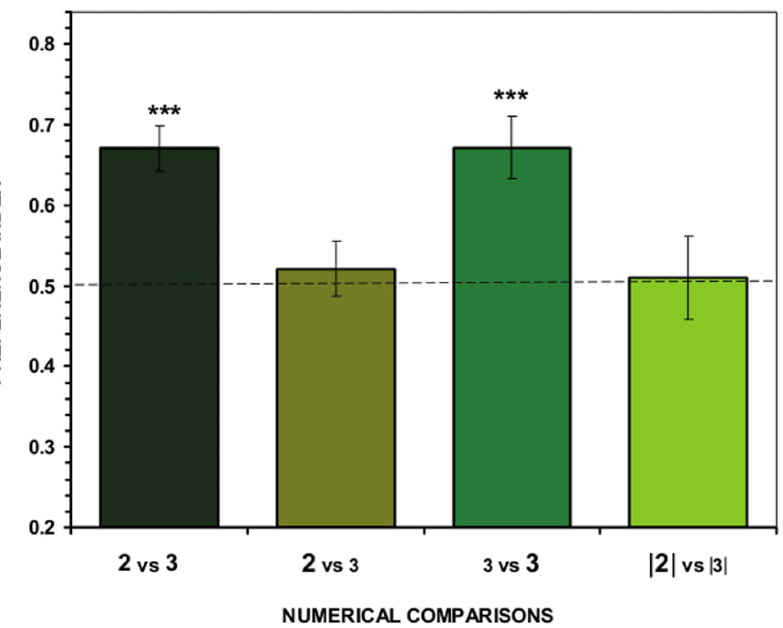
Figure 4. Results of Experiment 2. Proportion of time ( preference index , Mean 6 SEM) test fish spent in close proximity to the stimulus shoals. Values above 0.5 indicate a preference for the more numerous shoal of stimulus fish or a preference for the stimulus shoal with the greater overall surface area when the stimulus shoal is of the same numerical size. In the X-axis legend the numbers indicate the number of members of the contrasted shoals. We also illustrate the size of the body surface area: the large font size means that the body surface area of the stimulus fish was large and the smaller font size indicates that the surface area was small. Note that in case of the second condition (second bar) the total surface area of the two contrasted shoals was made similar by increasing the surface area of the individual stimulus fish in the less numerous shoal and decreasing it in the more numerous shoal. Numbers in between bars | | (fourth condition) represent stimulus shoals confined in small sectors of a transparent compartment which was designed to minimize differences in several continuous variables that may have covaried with the sizes of these shoals (see text for details). Significant departure from the null hypothesis of no shoal preference is indicated by asterisks: *** P , 0.001. Note that the difference between figures 3 and 4 is that in the latter the number of fish in the contrasted shoals is small (2 vs. 3).